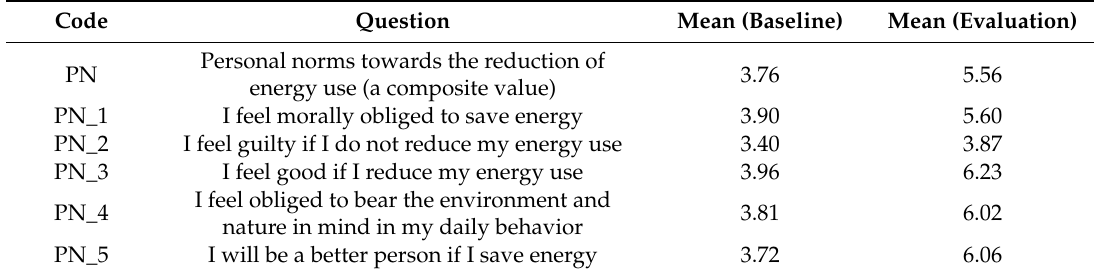
Table 8. Mean for perceived personal norms (PN) (totally disagree (1) to completely agree (7)). Code